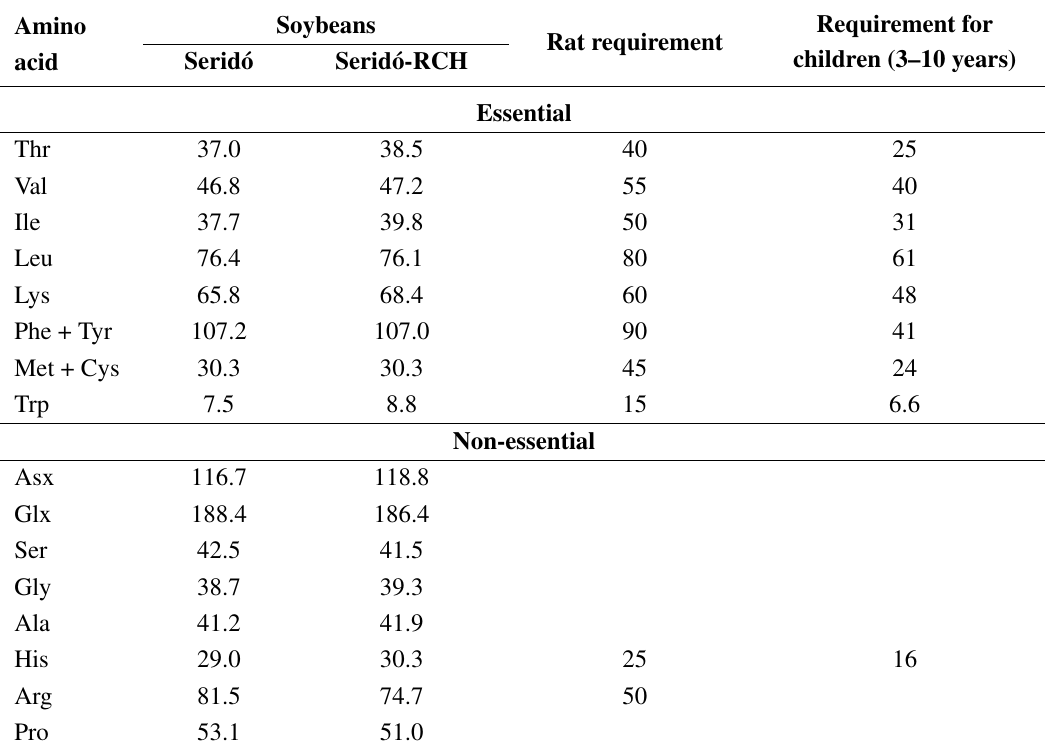
Table 3. Comparison of the amino acid composition (g/kg of protein) of the soybean cultivars with WHO/FAO/UNU [27] patterns of amino acid requirements for children and with those required for rats [21]